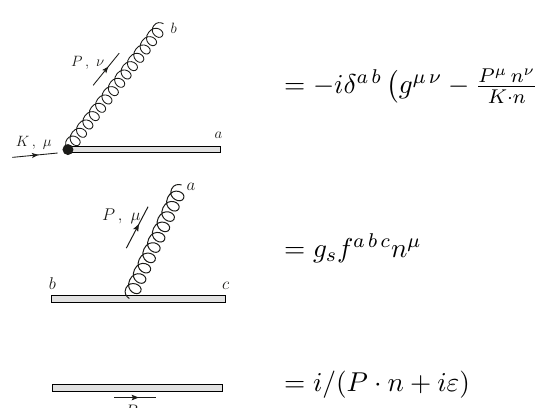
Figure 1 . Feynman rules related to the gluon gauge